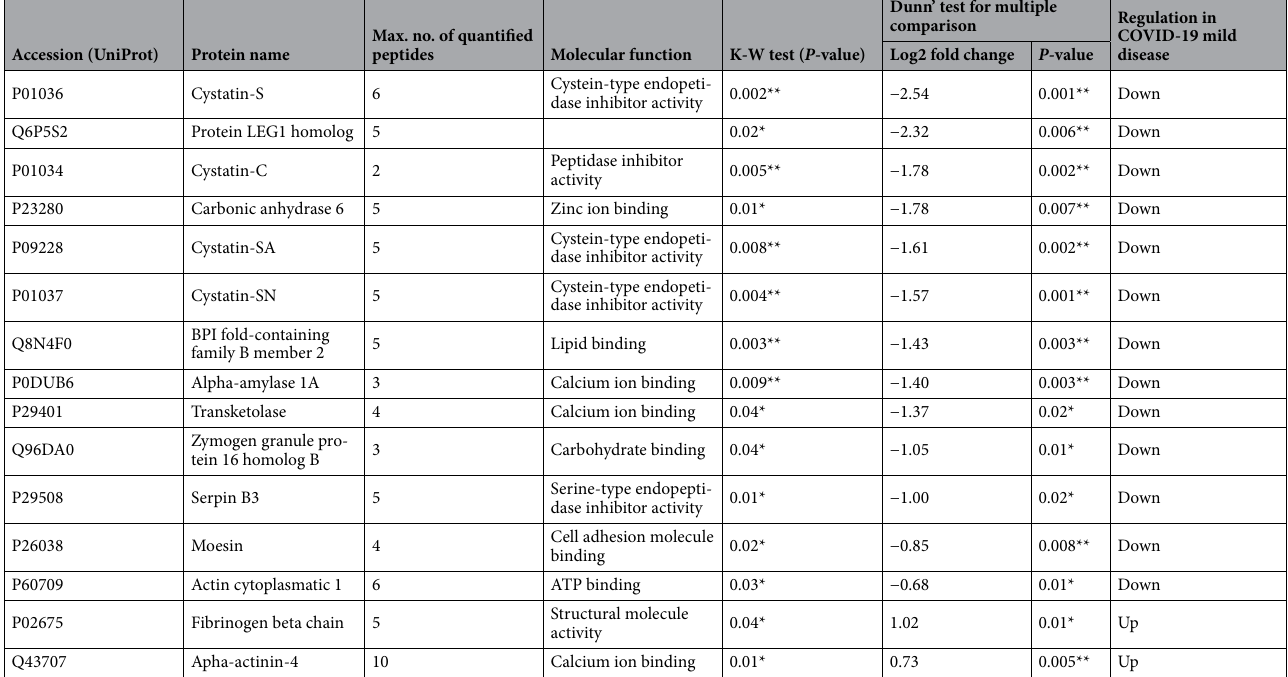
Table 3. Differentially expressed proteins in severe COVID-19 (n = 5) compared with healthy individuals (n = 10). K-W: